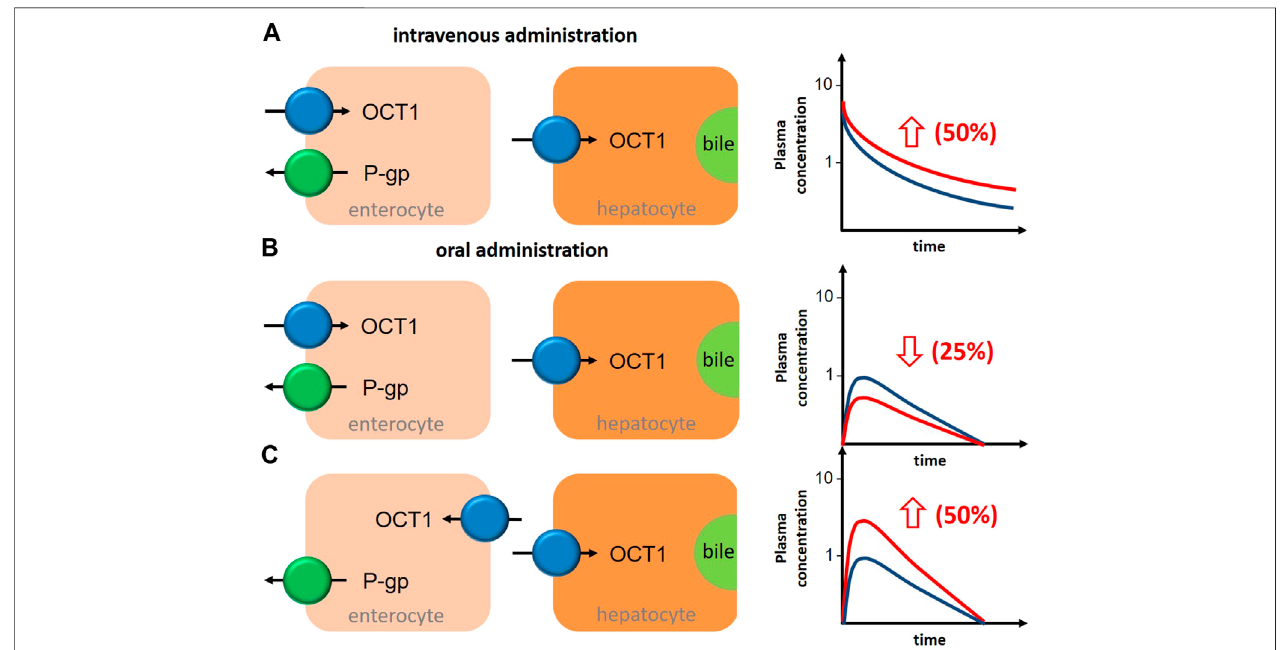
FIGURE 3 | Schematic illustration about the impact of OCT1 inhibition in human liver and intestine on the bioavailability of the victim drug in depencence on the localization of intestinal OCT1 and the route of drug administration. (A) , after intravenous administration of an OCT1 substrate, inhibition of hepatic OCT1 will increase systemic drug exposure by 50%. (B) , after oral administration of an OCT1 substrate, inhibition of intestinal (apical localization) and hepatic OCT1 will decrease oral bioavailability by 25%. (C) , after oral administration of an OCT1 substrate, inhibition of intestinal (basolateral localization) and hepatic OCT1 will increase oral bioavailability by50%.Generalassumptionsforallestimations:intestinaland hepaticuptakeofthedrugare50%and mediatedbyOCT1;OCT1inhibitionresultsin50% reduction in the intestinal absorption (fa) and/or hepatic uptake (blue graph, OCT1 substrate without inhibitor; red graph, OCT1 substrate with inhibitor).